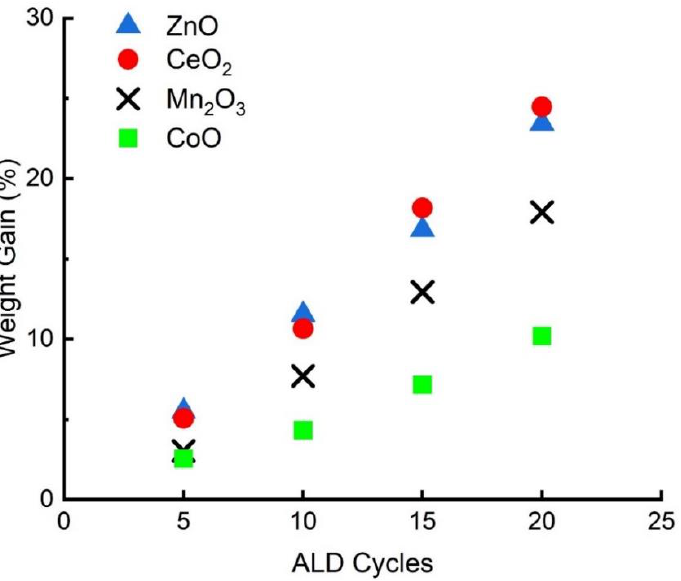
Figure 1. ALD Growth rates for the various oxides on